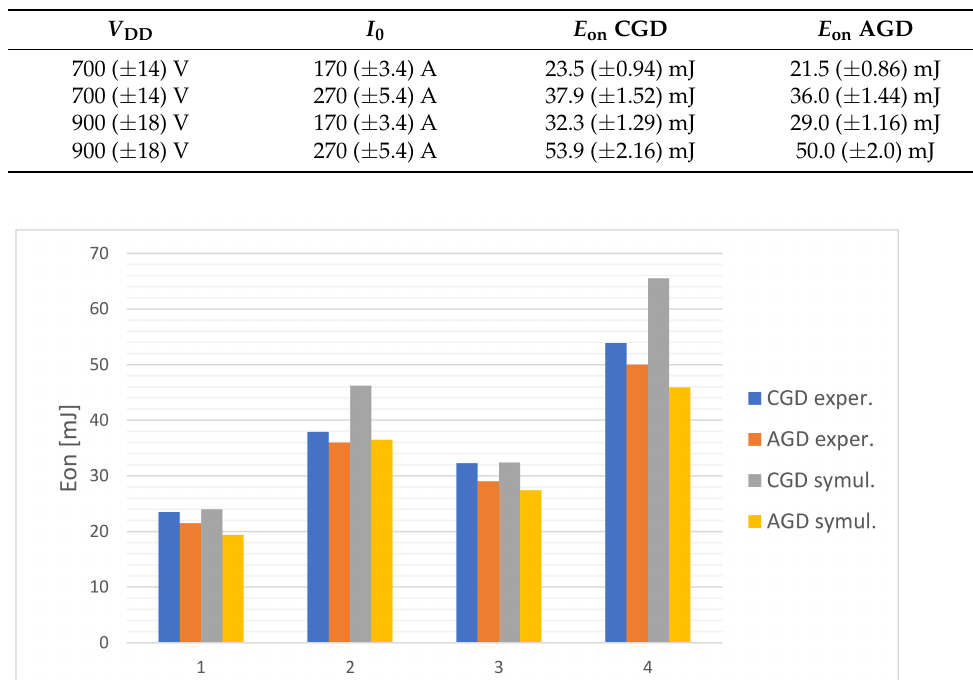
Table 2. The turn-on energy losses of AGD and CGD comparisons from the experimental test.